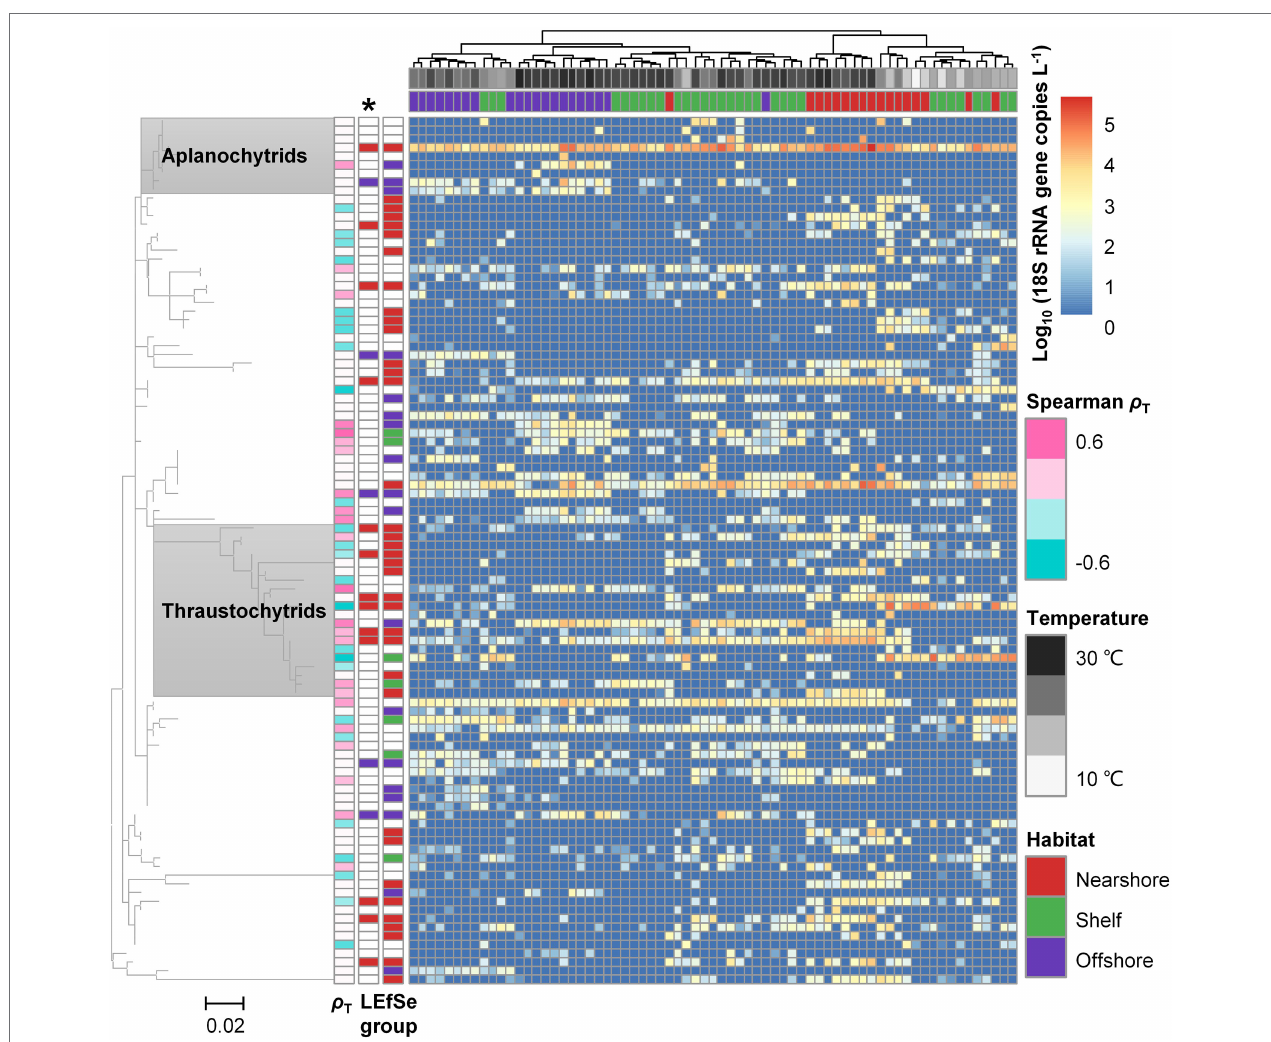
FIGURE 5 | Heatmap showing the estimated absolute 18S rRNA gene abundance variations and putative habitat preferences (assessed by LEfSe) of the 100 most abundant Labyrinthulomycete ASVs. The ASVs (rows) are organized by a maximum likelihood phylogenetic tree with the dominant and well-classified clades (aplanochytrids and thraustochytrids) labeled. Samples (columns) are clustered by similarity using Ward’s hierarchical agglomerative method and labeled with water temperature and sampling locations (nearshore station A, shelf stations B and C, and offshore stations D and E). The LEfSe affiliation columns with and without the asterisk above indicate all-against-all (more-strict) and one-against-all (less-strict) strategies performed for multiclass analysis, respectively. The ASVs are also annotated by Spearman correlation coefficients ( ρ T ) with water temperature when the correlations are significant (adjusted p < 0.05); the blank squares indicate the correlations are not significant (adjusted p >